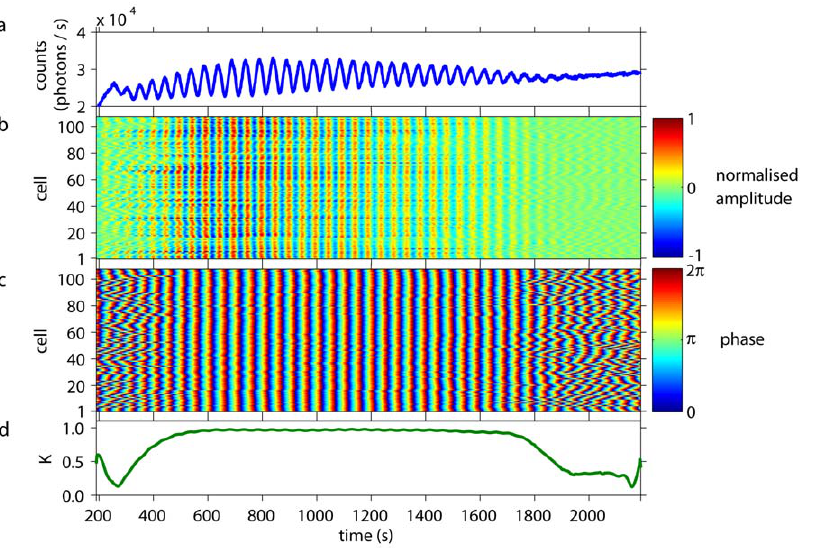
Figure 1. Collective and individual dynamics of a population of cells from S.carlsbergensis at a cell density of 0.7%. At t =0 an aliquot of 52 mM glucose was added to the starved and immobilised cells. During the first * 350 s of the time-series, the cells start to oscillate and to synchronise to each other. (a) The time-series of the macroscopic, collective fluorescence signal shows well-developed glycolytic oscillations. This coherent signal is generated by all cells of the population. (b) The oscillations of the individual cells show that their normalised amplitudes are highly coherent and synchronised. (The amplitude of oscillations of the cells corresponds to 60–140 photons/s.) Note that the dynamics of every cell is plotted as a thin line and its corresponding normalised amplitude is colour-coded. Cells are numbered randomly, i.e., the numbering does not reflect any spatial arrangement of the cells. At t w 1800 s the oscillation amplitudes decay and the cells lose synchrony due to exhaustion of glucose. (c) The phases of the oscillations of the individual cells are highly synchronised to each other. Again, for t w 1800 s the cells desynchronise. (d) The time- dependent Kuramoto order parameter K indicates the degree of synchronisation among the cells. For 350 s ƒ t ƒ 1800 s the order parameter is almost 1, indicating a very high coherence in the oscillations of the individual cells.